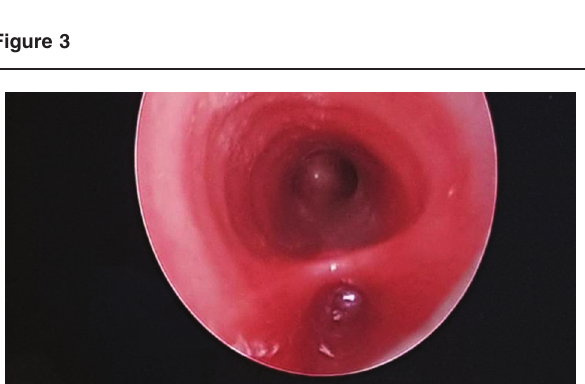
Intraoperative finding (fistula seen).